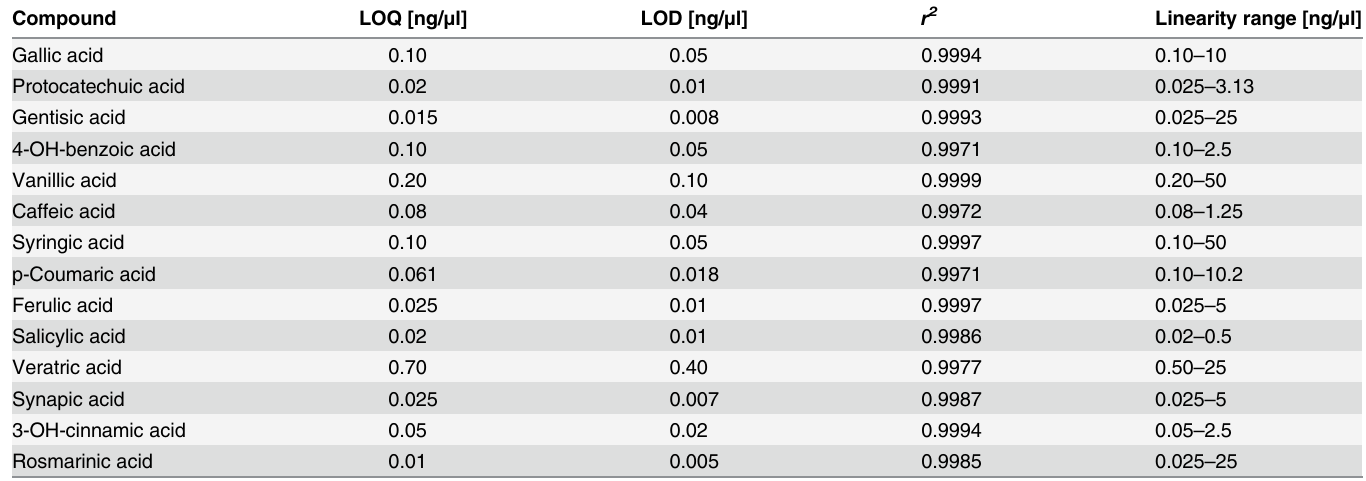
Table 3. Analytical parameters of LC-ESI-MS/MS quantitative method; data for calibration curves, limit of detection (LOD) and limit of quantifica- tion (LOQ) values for each analyzed phenolic acid.